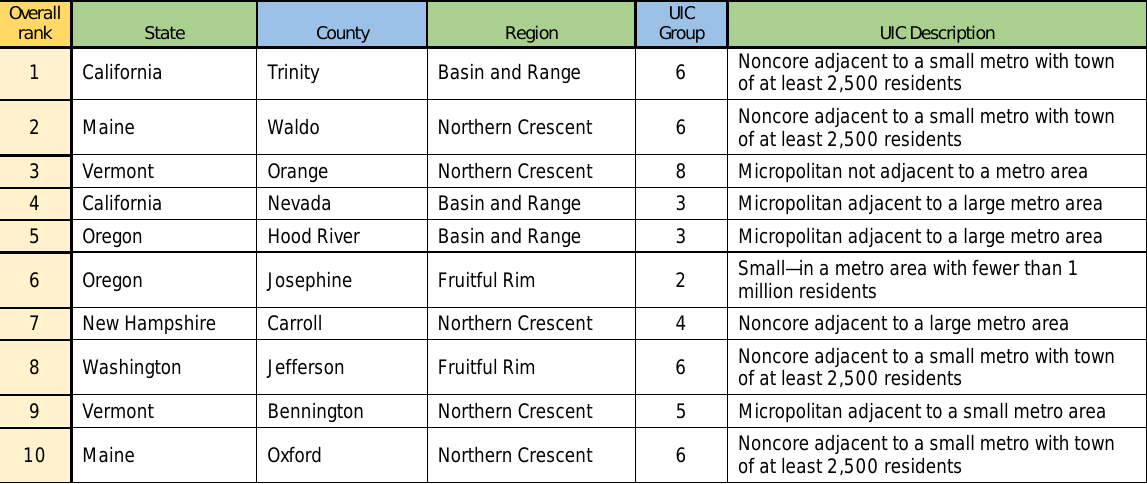
Table 3. EXCERPT FROM Progressive Agriculture Index Top 100 Counties Overall, 2012